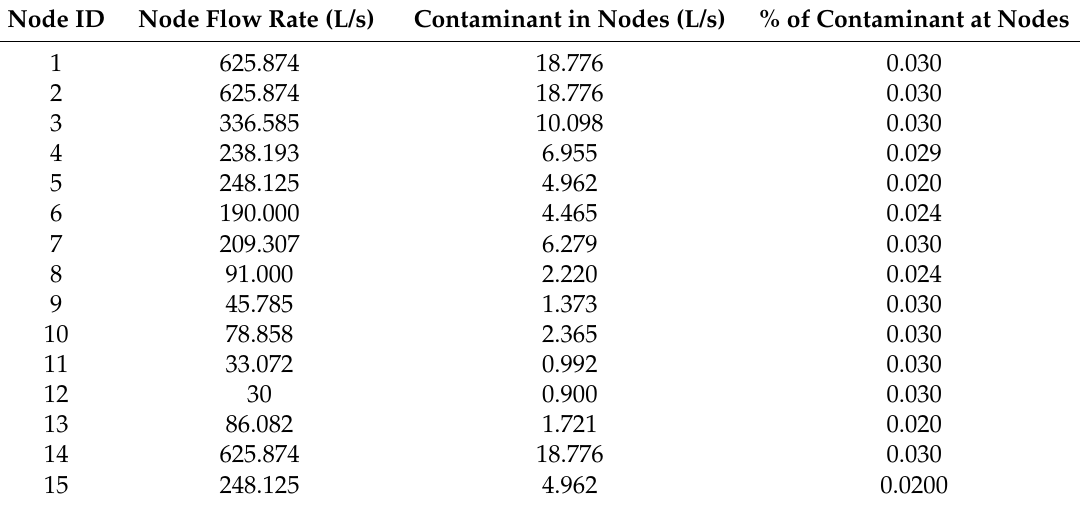
Table 3. Numerical results for illustrative Example 1 for the